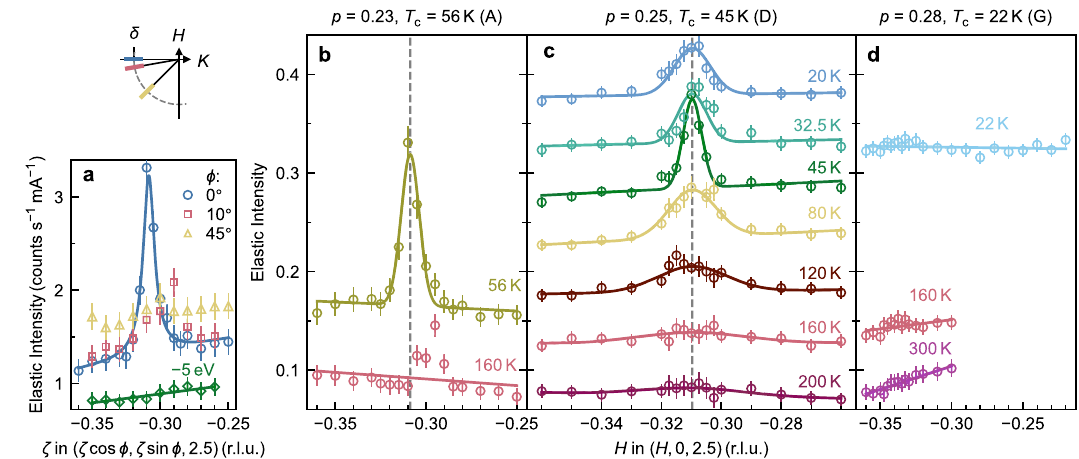
Fig. 3 Wavevector-dependent scans of the CDW order. Elastic intensities, obtained integrating RIXS intensity over energy in the range − 100 < E < 100 meV, of three samples of Tl2201 at various dopings. a Scans along lines ð ζ cos ϕ ; ζ sin ϕ ; 2 : 5 Þ showing CDW order occurs near ( − 0.31, 0, 2.5) and off-resonance scan with ϕ = 0 for p = 0.23. Measurements are normalised to the storage ring current. The sketch above indicates the direction of the scans in the ( H , K ) plane. b – d ( H , 0, 2.5) scans, with intensities normalised to the dd excitations. Measurements at successively lower temperatures in c have been offset by a value of 0.05 units per temperature. Data has been fi tted to a Gaussian with standard deviation parameter σ plus linear background. The grey dashed line marks the centre of the Gaussian peak at T c , which we have used to determine δ